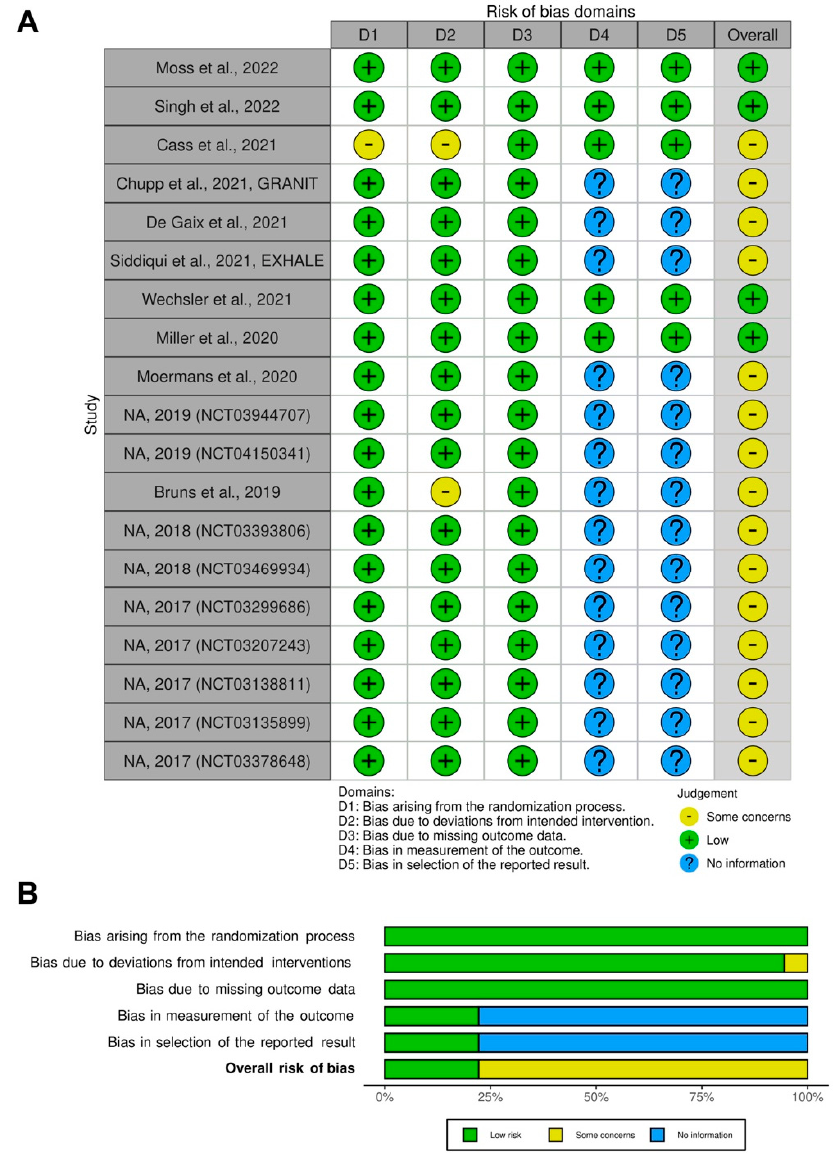
Figure 2. Assessment of the risk of bias via the Cochrane RoB 2 tool displayed by means of a traffic light plot of the risk of bias of the included RCTs ( A ), and weighted plot for the distribution of the overall risk of bias within each bias domain via the Cochrane RoB 2 tool ( B ) (n = 18 RCTs). Traffic light plot reports five risk of bias domains: D1, bias arising from the randomisation process; D2, bias due to deviations from intended intervention; D3, bias due to missing outcome data; D4, bias in measurement of the outcome; D5, bias in selection of the reported result. Yellow circle indicates some concerns on the risk of bias, green circle represents low risk of bias, and blue circle indicates no information. NA: not available; RCT: randomised controlled trial; RoB: risk of bias.